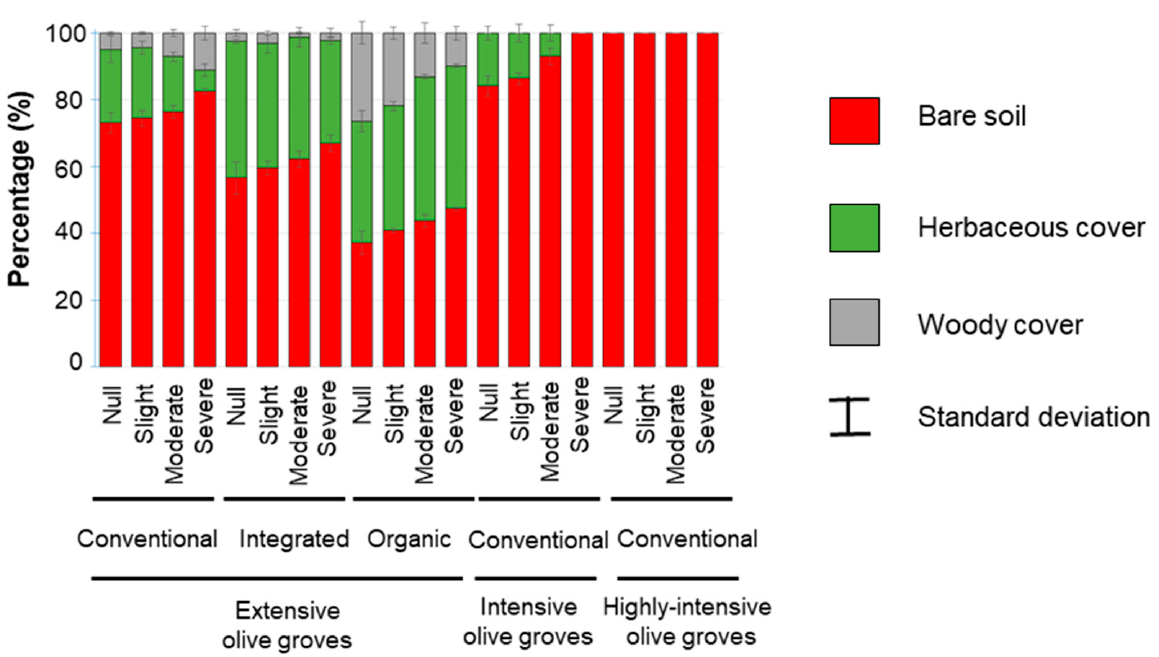
Figure 5. Mean values and standard deviations for plant cover (i.e., bare soil, herbaceous and woody covers) synthesized for each erosion level and type of olive grove.